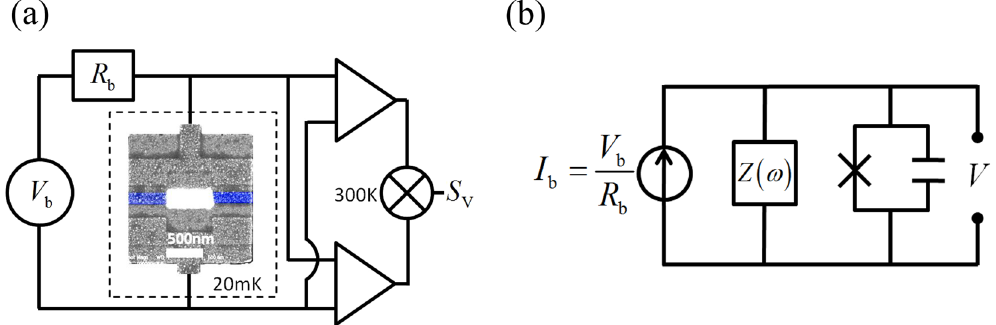
Figure 3. Experiment setup ( a ) Noise measurement circuit diagram including an SEM image of the JJ under study. The junction area is marked by the blue rectangles. The junction is current biased via a series resistor R b of 1 MΩ, and S V (0) is measured with two voltage amplifiers whose outputs are cross-correlated. ( b ) The equivalent measurement circuit, in which Z ( ω ) represents a shunting impedance seen by the JJ.